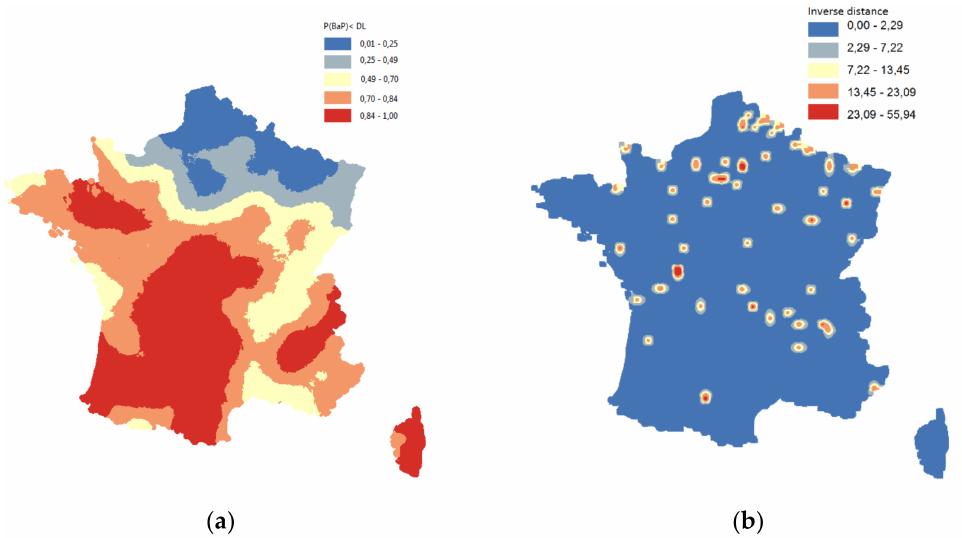
Figure 5. Auxiliary variables to be used in the modeling of B[a]P soil concentration in France. ( a ) Indicator kriging map for the concentrations under the detection limit for B[a]P. ( b ) Source proxy, constructed as a function of inverse distance from the polluted sites (km − 1